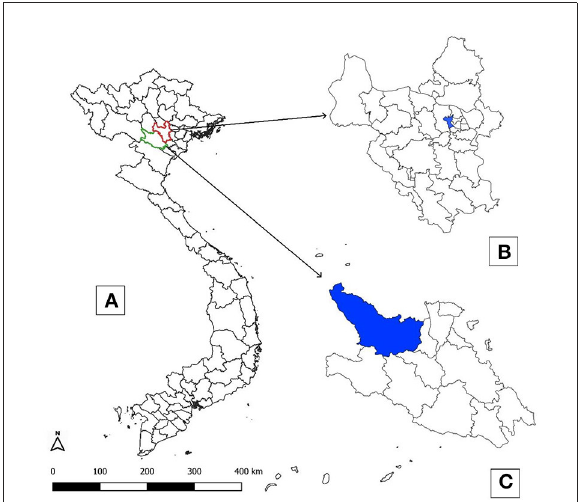
FIGURE1 Map of study sites in Da Bac district, Hoa Binh province and Cau Giay district, Hanoi city, Vietnam. (A) Map of Vietnam with Hoa Binh province highlighted in green and Hanoi city highlighted in red. (B) Hanoi city with Cau Giay district highlighted in blue. (C) Hoa Binh province with Da Bac district highlighted in